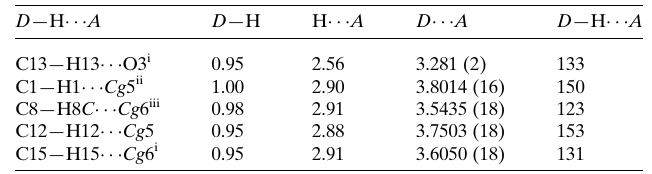
Table 1 Hydrogen-bond geometry (A˚ , (cid:4) ) for 3 . Cg 3 is the centroid of the C11–C16 ring.